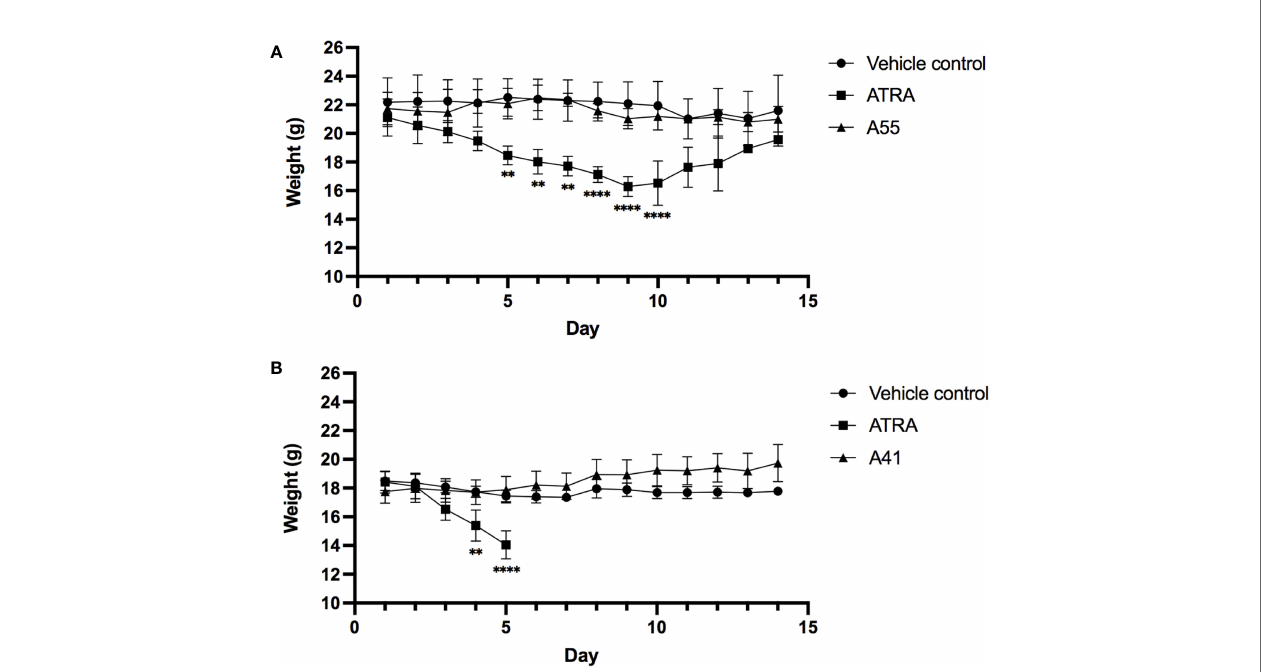
FIGURE 6 | Mice inoculated with K7M2 cells were treated daily with either vehicle control (n=4), rexinoid A55 (n=5), or ATRA (n=4), delivered i.p. at a previously determined concentration of 40mg/kg for 14 days, or with vehicle control (n=5), rexinoid A41 (n=6), or ATRA (n=5) delivered orally at 100mg/kg for 14 days. (A) Mice that received A55 treatment i.p. had weight loss similar to negative control mice, while mice that received ATRA treatment displayed signi fi cantly larger weight losses during treatment (** = p < 0.005, **** = p < 0.0001). (B) Mice that received high dose oral A41 treatment showed slight weight gain, while ATRA-treated mice displayed signi fi cant weight loss that necessitated removal from study (** = p < 0.005, **** = p < 0.001). All error bars represent SD from the